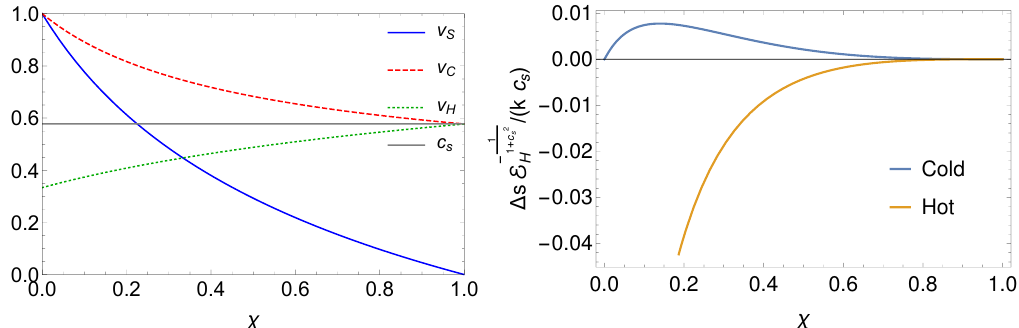
) , and the left- and right- S and v in comparison to the sound velocity c for d = 3 C H s (cid:112) E / E . ‘Cold’ refers to the left-moving and ‘Hot’ C H